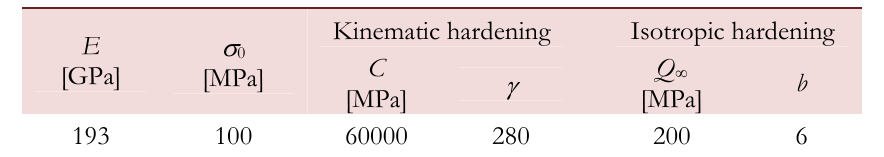
Table 1: The material parameters for SS316L [13].